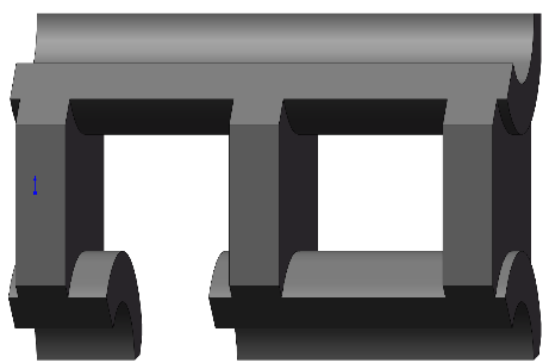
Figure 7. Hollow drive rod model.